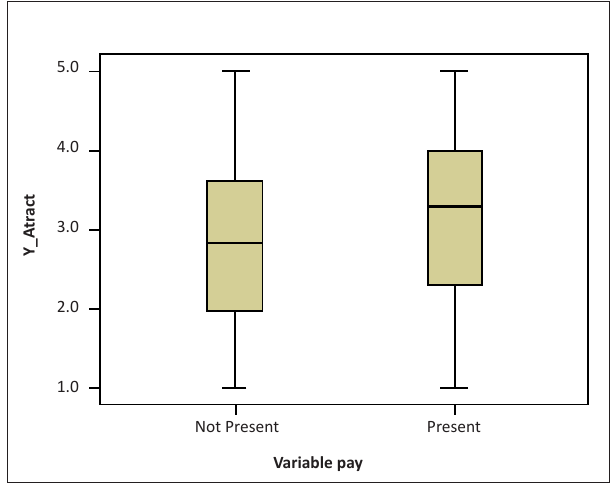
FIGURE 6: Box plot of a reward package consisting of benefits and variable